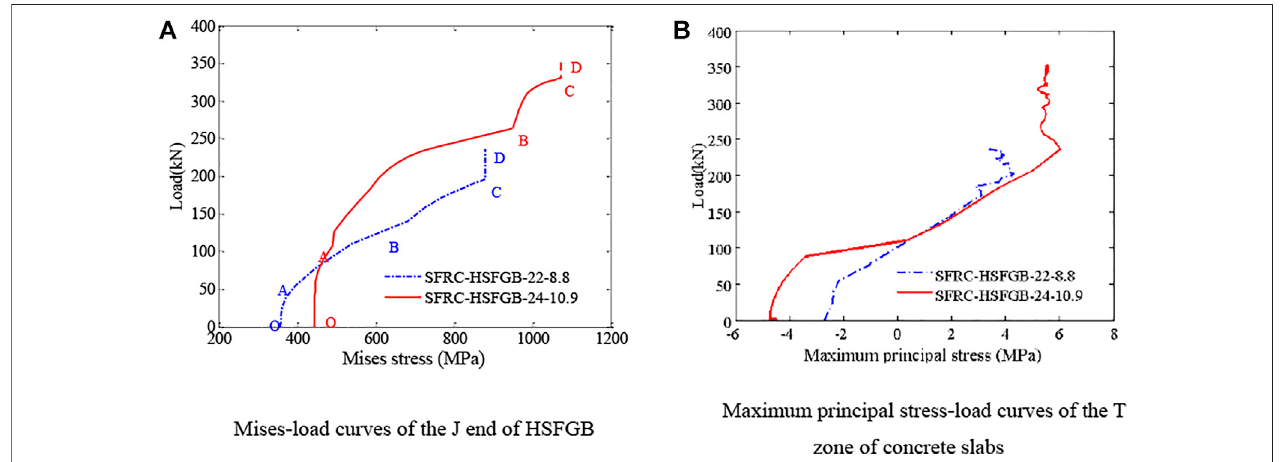
FIGURE 9 | The stress-load curves of HSFGBs and concrete slabs in specimens.